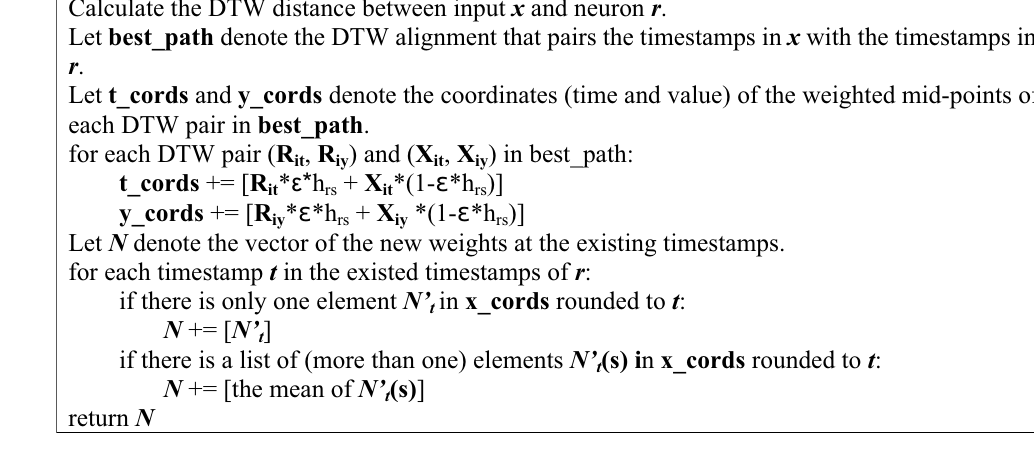
Table 1. Pseudo code of DTW-SOM updating